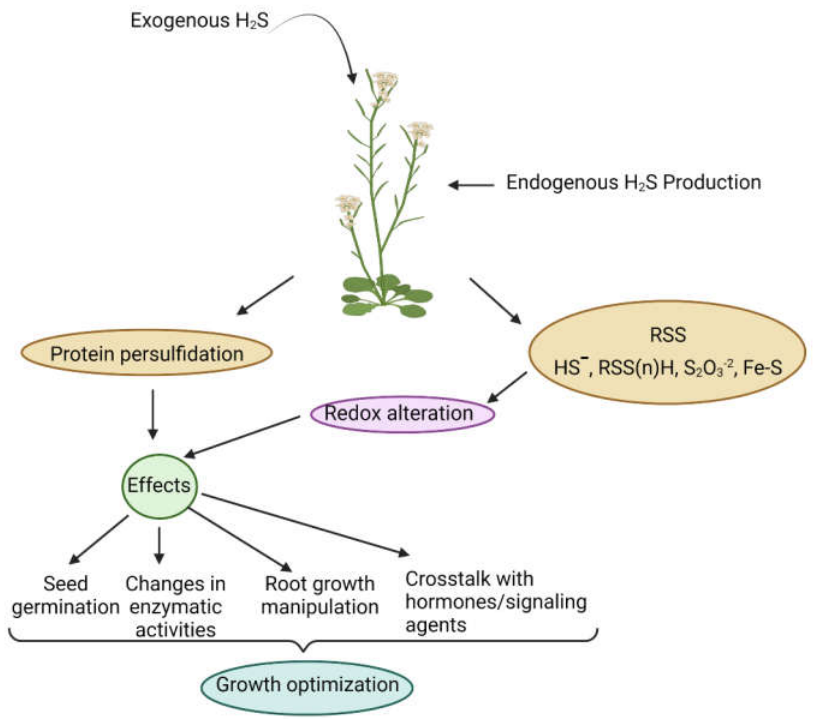
Figure 1. Overview of hydrogen sulfide (H 2 S) production and the regulation of several physiologi- cal, metabolic, and morphological processes by H 2 S to optimize growth in plants. metabolic, and morphological processes by H 2 S to optimize growth in